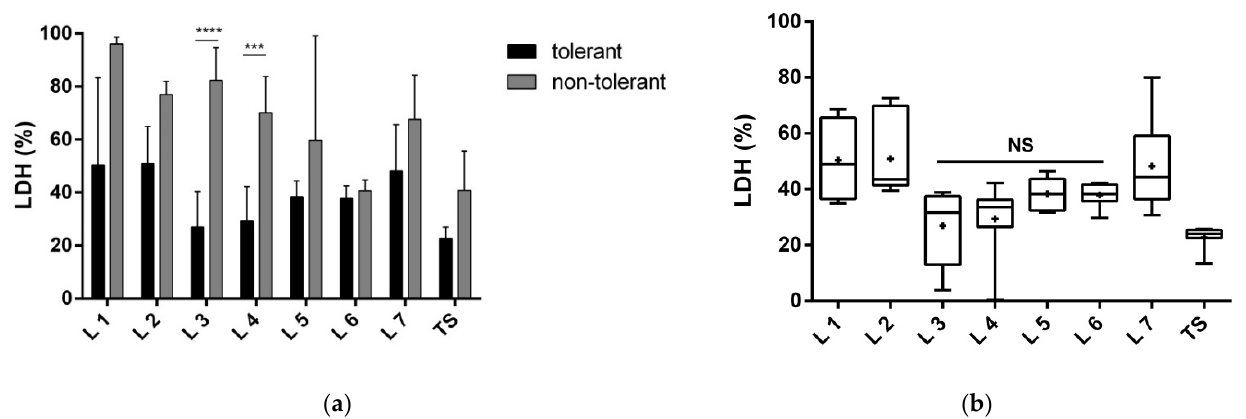
Figure 3. Lactate dehydrogenase (LDH) released by neurons after exposure to 200 µM glutamate and co-cultivation with the total tolerant or non-tolerant secretomes or their fractions. Protein fractions 1–7 of the total secretomes were separated with native polyacrylamide gel electrophoresis. The LDH content is expressed as a percentage of neurons exposed to 200 µM glutamate. The tests were performed after 24 h of incubation in four replicates of three cultivations. ( a ) Comparison of the neuroprotective effect of tolerant versus non-tolerant secretomes and their respective fractions. The data are presented as the mean ± standard deviation (*** p < 0.001; **** p <0.0001). ( b ) Comparison of the neuroprotective effect of the fractions of the tolerant secretome to the total secretome. The graph shows the minimum to the maximum values with the median bar; + indicates the mean. NS, nonsignificant changes in the LDH content, compared with the total secretome; TS, total secretome.